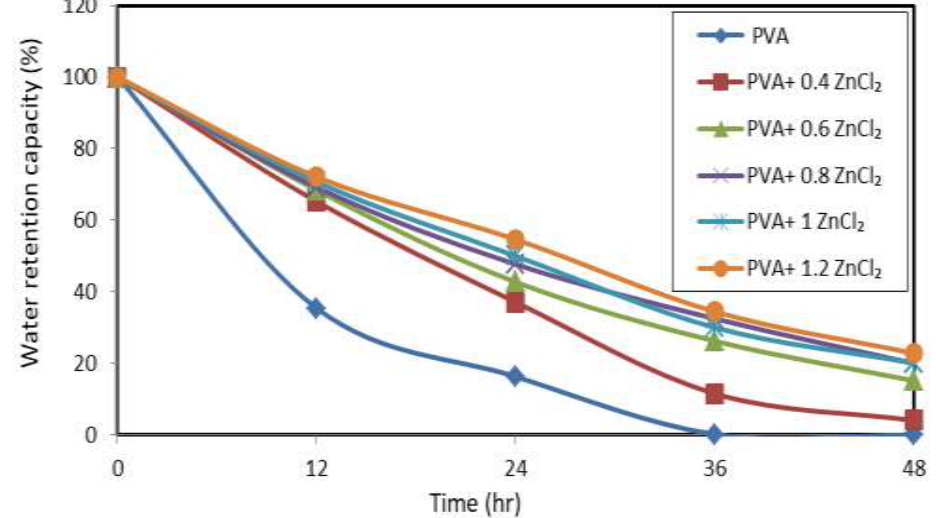
Figure 11 : Water retention capacity (%) of PVA and (Zn-PVA)